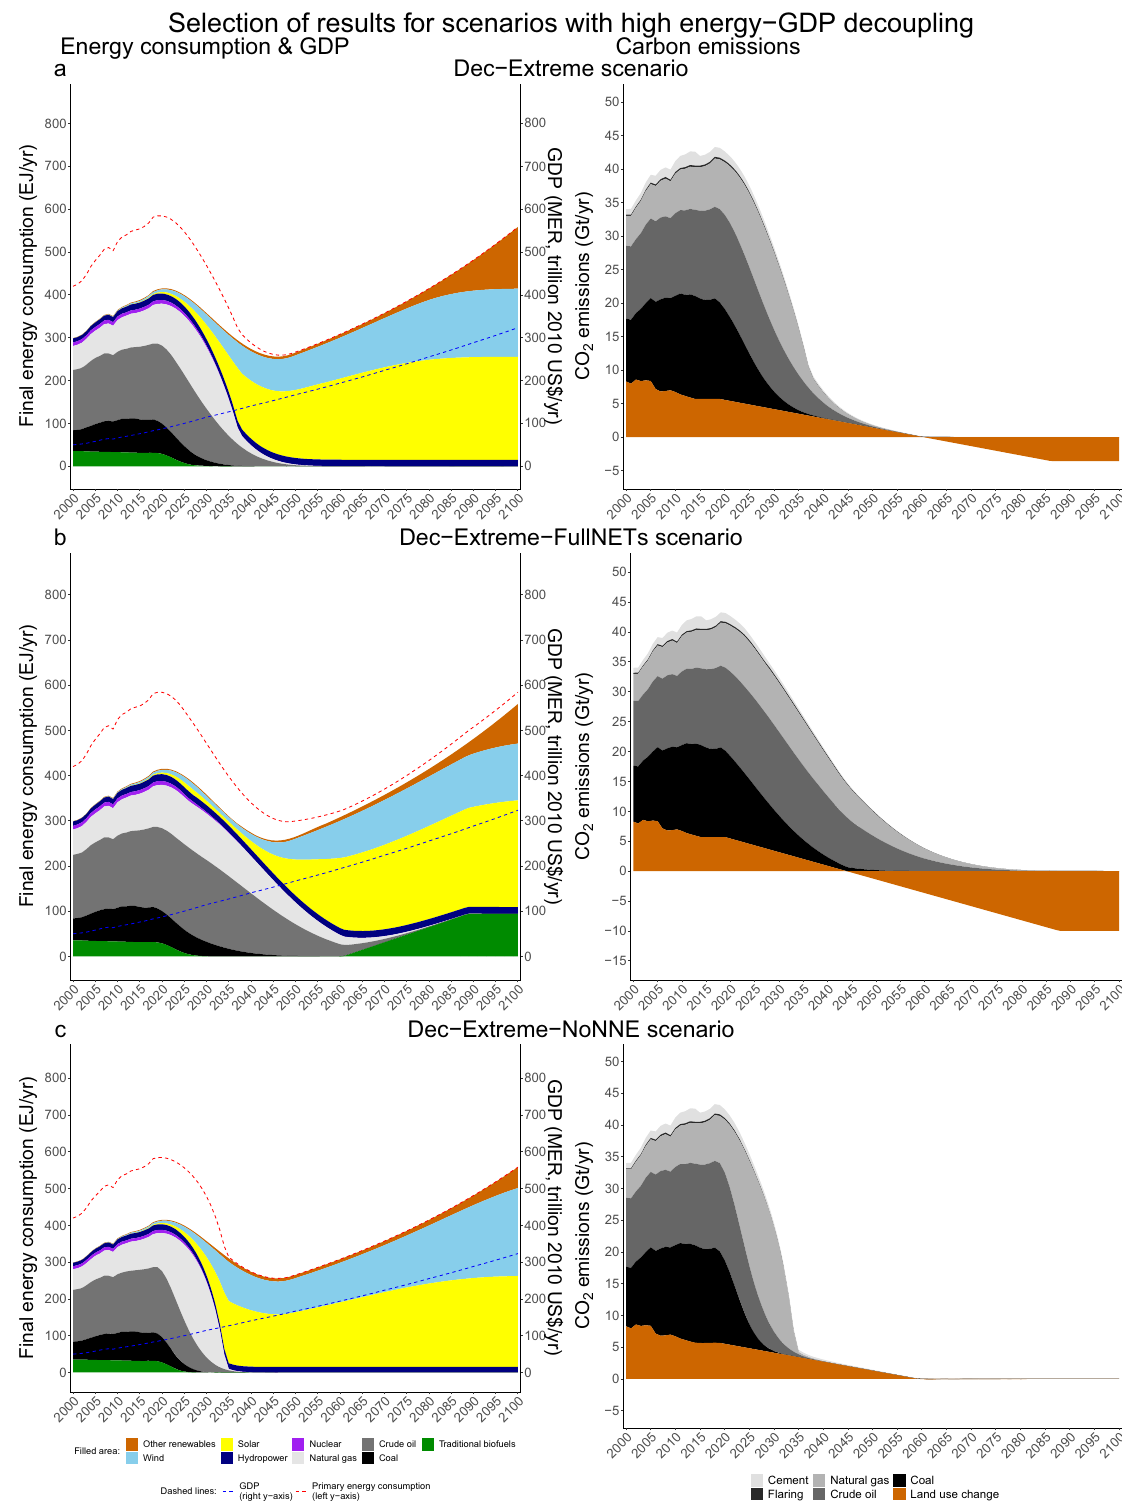
Fig. 4 Selection of 1.5°C scenarios with high energy-GDP decoupling. Selection of 1.5 °C scenarios with high energy-GDP decoupling ( a – c ). On the left, fi nal energy consumption (in EJ, left axis), aggregate primary energy consumption (in EJ, red dashed line, left axis) and GDP (MER, in trillion 2010 US$, blue dashed line, right axis). On the right, carbon emissions (in GtCO2./yr). The full collection of scenarios can be found in Supplementary Fig.